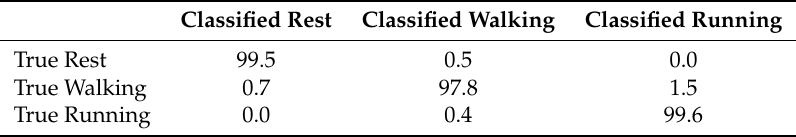
Table 8. Confusion matrix, using the smart annotation model (SA-AXGZ8), of continuous data including walking, running and rest on a per sample basis. All calculated per person and then per class and displayed as a